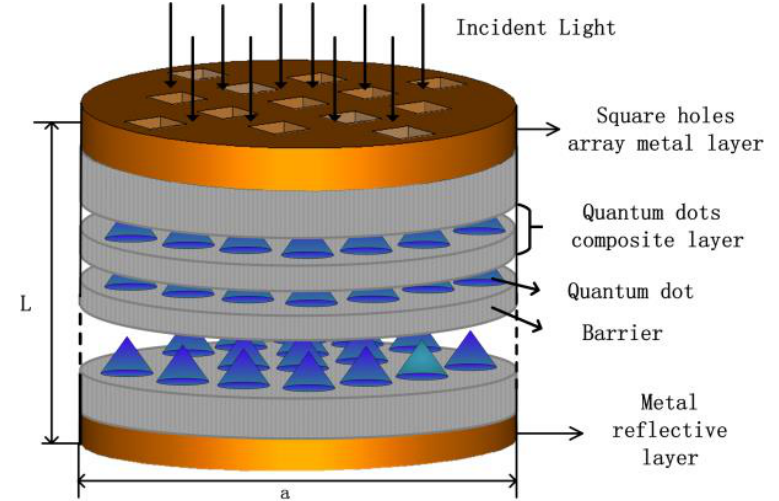
Figure 1. Quantum dot detector with the MSM cavity structure.